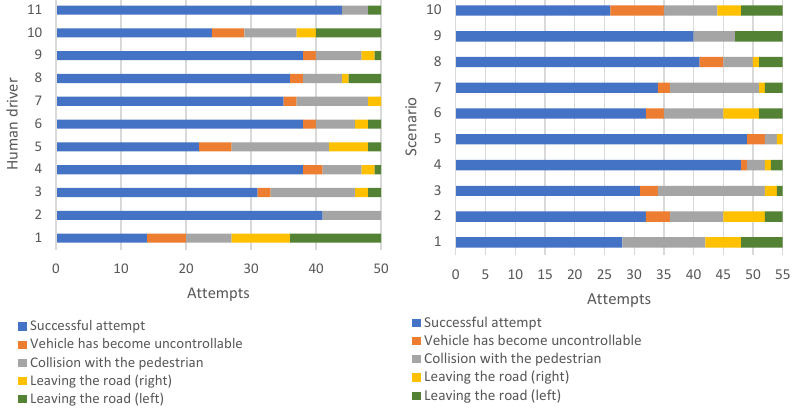
Figure 8. Distribution of successful and unsuccessful cases per human drivers ( left ) and per scenarios ( right ).